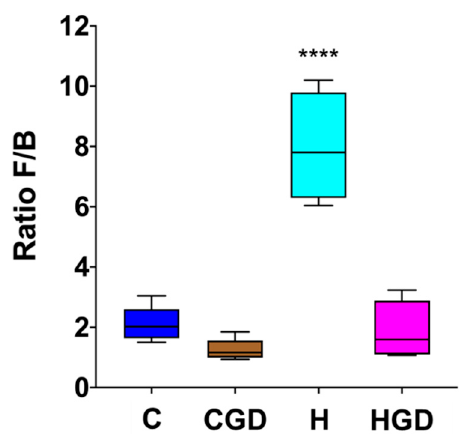
Figure 9. Effect of supplementation of diet (C or H) with Garcinia dulcis rind powder on the ratio of Firmicutes and Bacteroidetes (F/B) abundances in rat faecal samples. C, corn starch diet-fed rats; CGD, corn starch diet-fed rats treated with Garcinia dulcis rind powder; H, high-carbohydrate, high-fat diet-fed rats; HGD, high-carbohydrate, high-fat diet-fed rats treated with Garcinia dulcis rind powder. A one-way ANOVA was performed, significant differences were observed between H samples and the other treatments (C, CGD and HGD; p < 0.0001, ****).